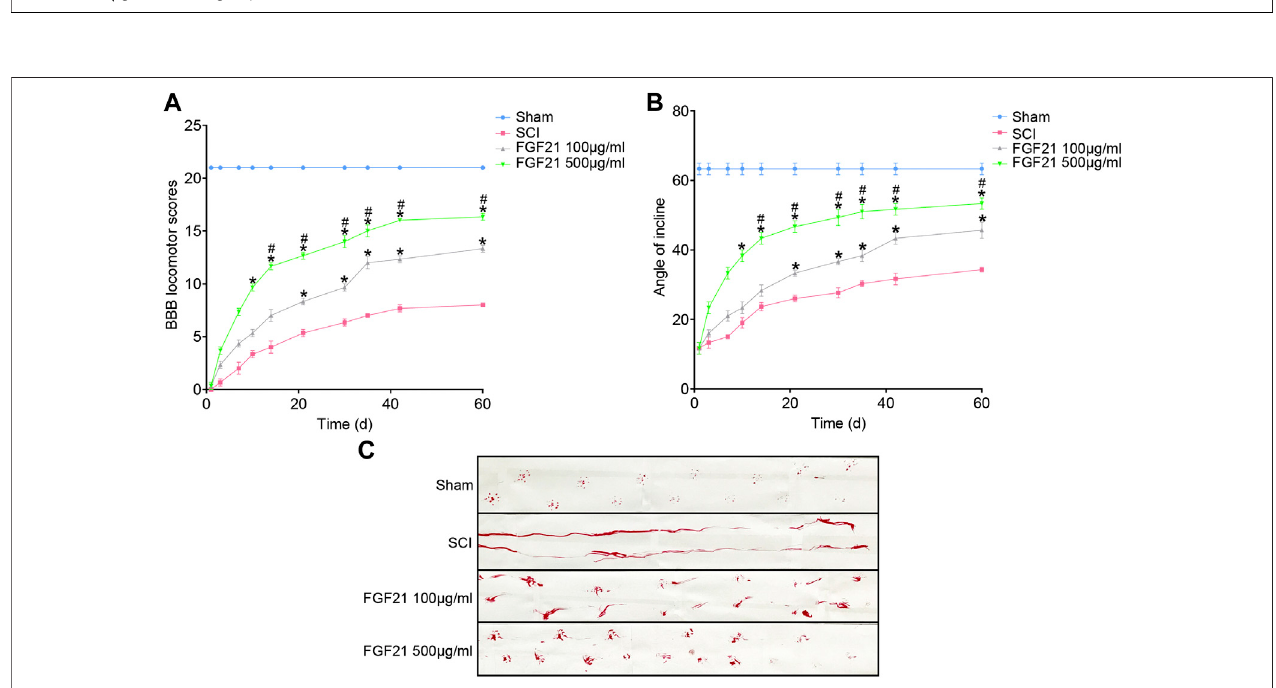
FIGURE 2 | FGF21 treatment facilitates locomotor function after SCI (A,B) Assessment of BBB scale and inclined plane test for each group. BBB score of 21 representedbytheshamgroupisregardedasfullscore.Representationofdataismeanvalues ± SEM, n (cid:1) 6, “ * ” and “ ** ” represent p < 0.05or p < 0.01vstheSCIgroup, “ # ” represent p < 0.05 vs the 100 μ g/ml FGF21 group (C) Image of footprint analyses of sham, SCI group, 100 μ g/ml FGF21 group and 500 μ g/ml FGF21 group.